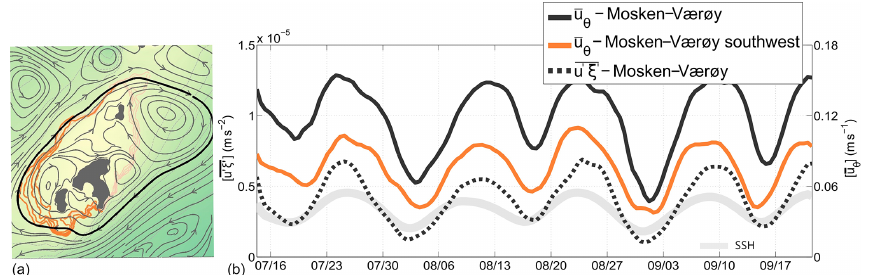
Figure 17. Close-up of the flow field around Mosken–Værøy. Panel (a) shows time-mean streamlines (gray contours with arrow heads) as well as a set of depth contours that wrap around the island group (orange contours). Panel (b) shows the Reynolds vorticity flux (dashed black line) through one closed streamline which wraps around the island group and the anticyclone east of Mosken (thick black contour in a ). Also shown is the circulation around the same contour (solid black line) as well as the circulation along an incomplete depth contour south and west of the island group (solid orange line). The sea surface height variation is shown with a thick light gray